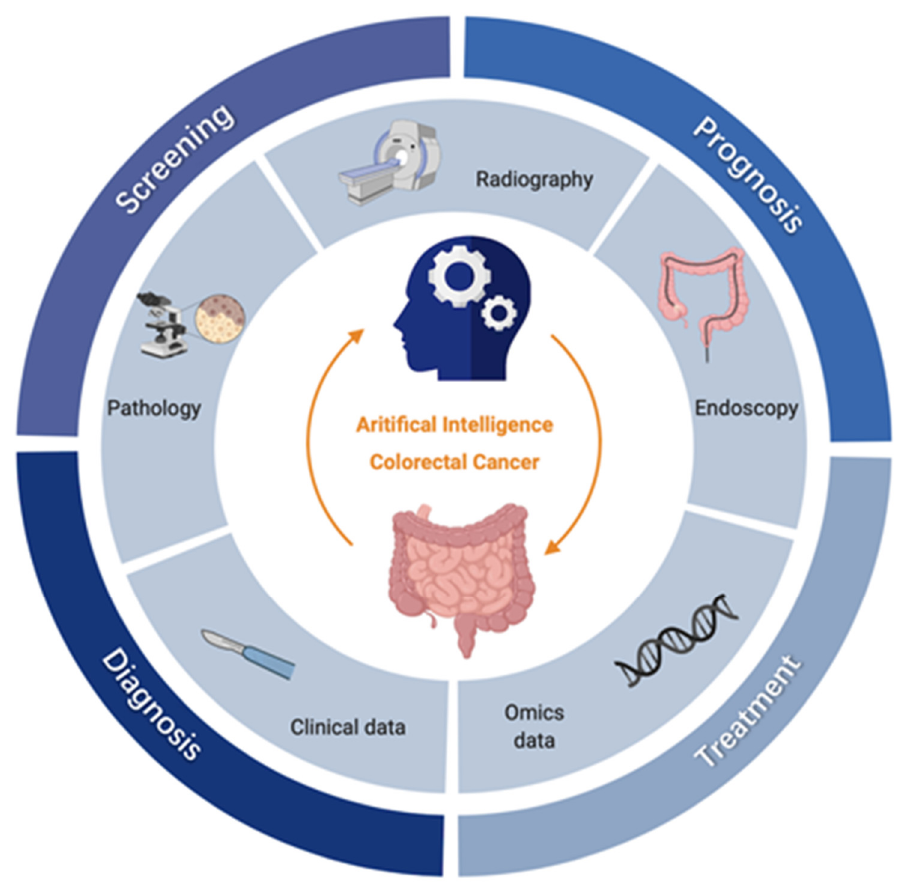
Figure 1. Clinical applications of AI for CRC. The inner circle represents the main data types in CRC research, including radiological images (i.e., Computed Tomography (CT), Magnetic Resonance Imaging (MRI), etc), endoscopic images, pathological images, clinical data, and omics data; the outer circle represents the four key clinical parts of CRC, i.e., screening, diagnosis, treatment, and prognosis; for each clinical part, AI has subdivided and specific tasks, which are shown in boxes outside the circle respectively. OS, overall survival; DFS, disease-free survival; nCRT, neoadjuvant radiotherapy.